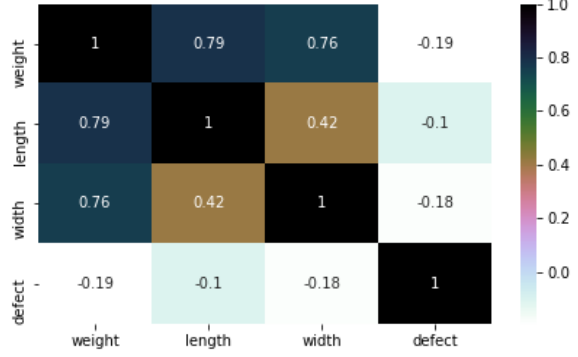
Figure 18. The relationship between the features of mangoes.